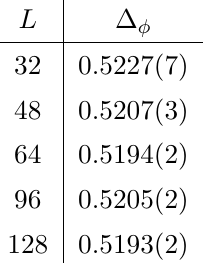
Table 1 . Scaling dimensions obtained from the fit for each system size. As final value, we take their average: ∆ = 0 . 5206(15) φ